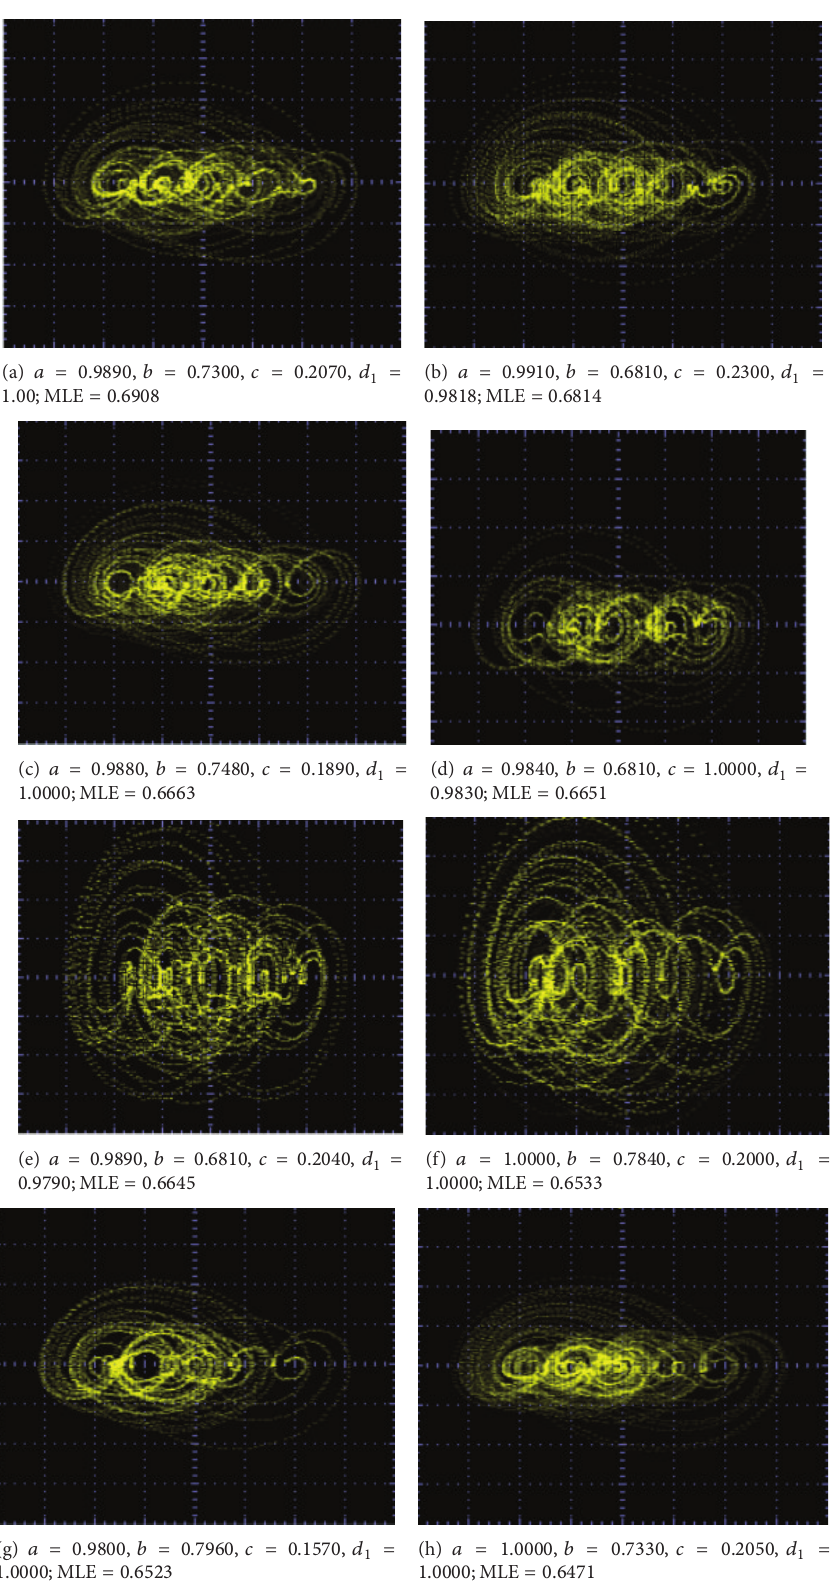
Figure 11: Optimized MLE for generating 5